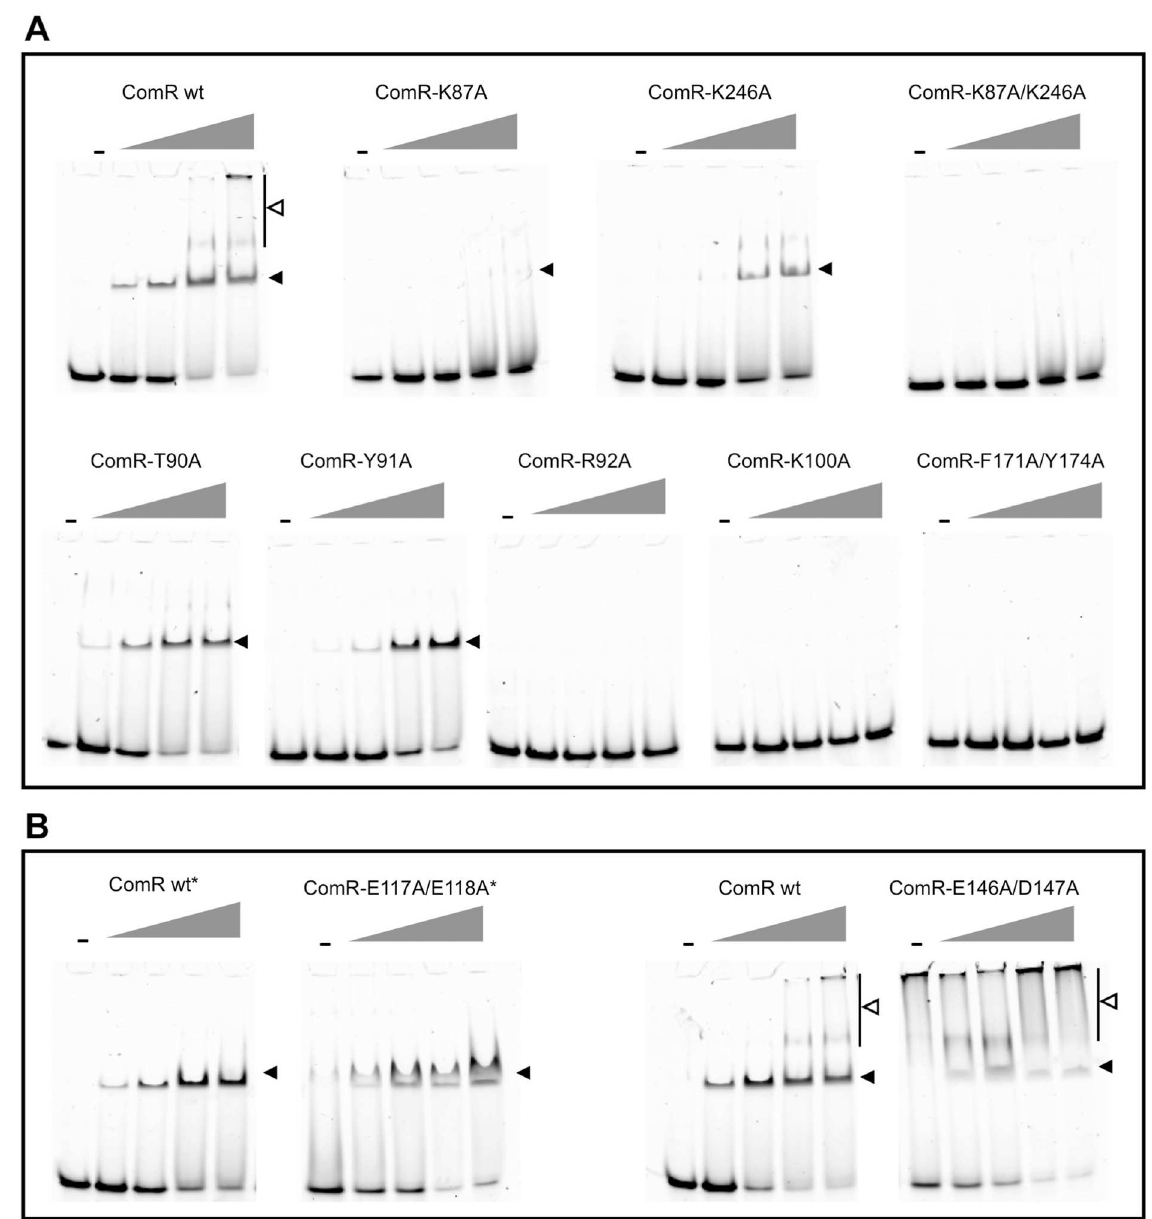
Fig 5. DNA binding activity. A–EMSAs performed with ComR mutants affected in dimerization, XIP binding, and activation mechanism (K87A, K246A, K87A/K246A, T90A, Y91A, R92A, K100A, and F171A/Y174A). B–EMSAs performed with ComR mutants affected in HTH sequestration (E117A/E118A and E146A/D147A). EMSAs reactions containa 40-bp dsDNA encompassing the ComR-box (Cy3-boxP ster_1655 wt; 40 ng) and either WT (control) or mutant ComR proteins. Reactionswere incubatedin the absence(-) or presenceof XIP. ComR was used at final concentration of 4 μ M, except for mutant ComR(E117A/ E118A) where a maximum concentration of 3.5 μ M could be reached( * ). The gray trianglesrepresent increasing XIP concentrations: 0.2, 0.4, 0.8 and 1.2 μ M. The well-defined ComRS-DNAcomplexand multimeric complexesare respectively indicatedby closed and openedarrow heads. One representative experiment of at least 2 independentreplicates is shown.